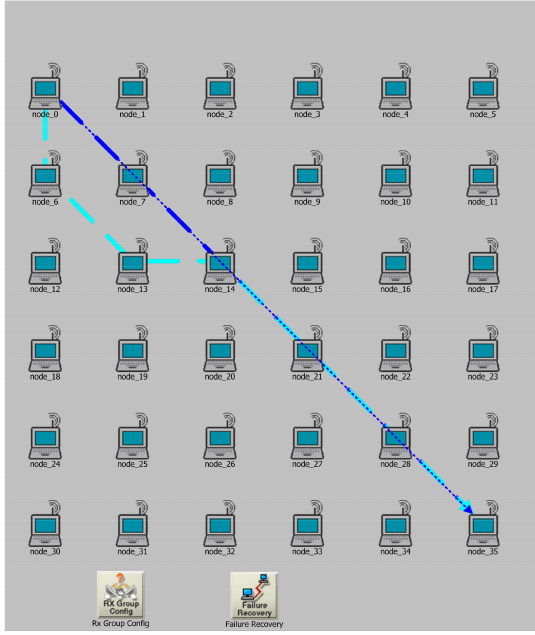
Figure 8. Changes in routing after node _7 is